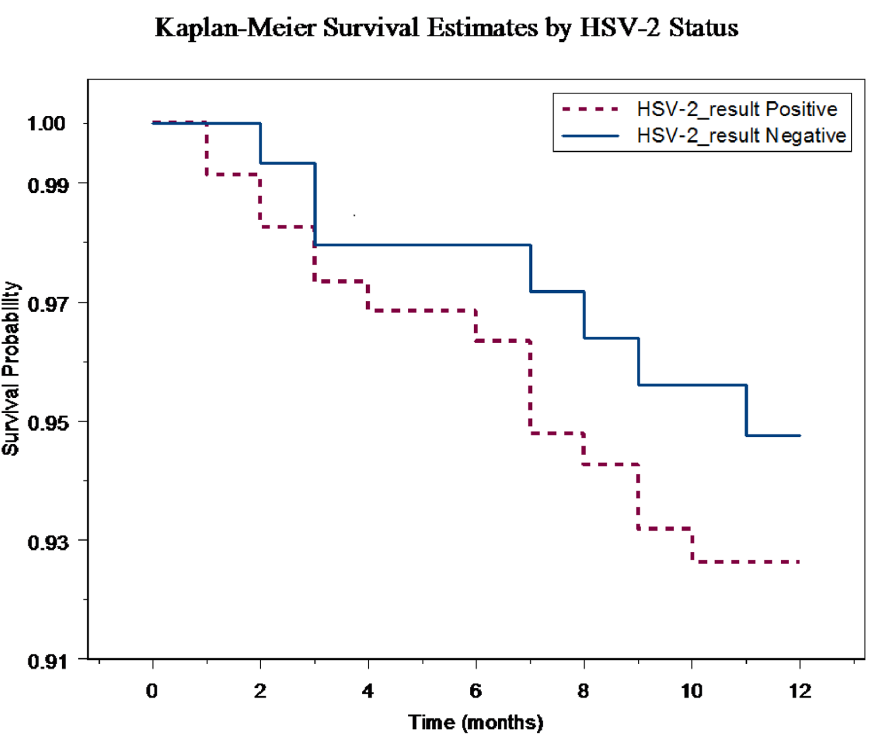
Figure 2. Kaplan-Meier curves for time to HIV seroconversion according to HSV-2 status at baseline.